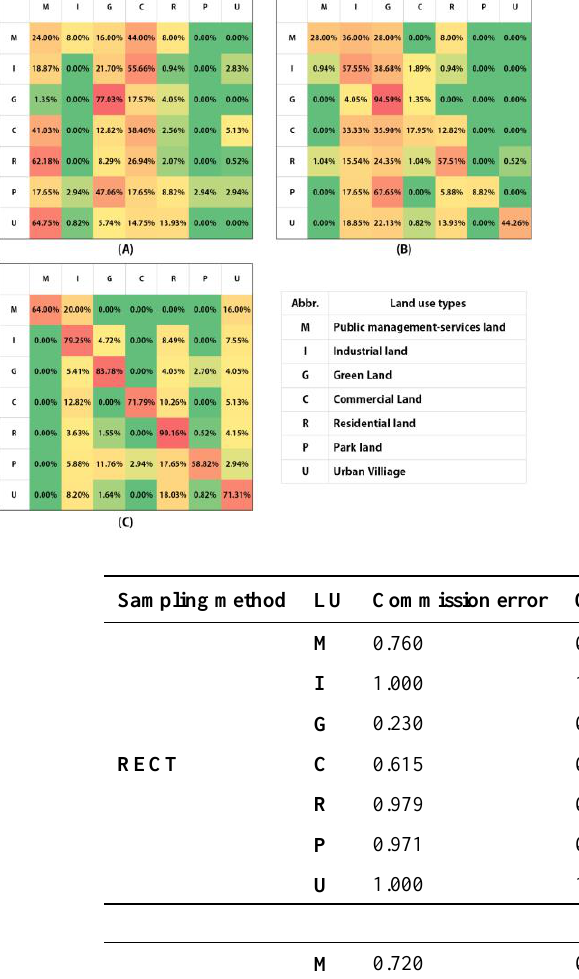
Figure 7. Confusion matrixes of urban land-use classification results for the different methods: (A) RECT; (B) RAND and (C)